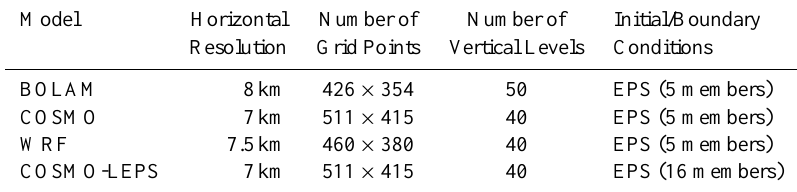
Table 1. Model set-up: horizontal and vertical resolutions, grid characteristic and initial/boundary